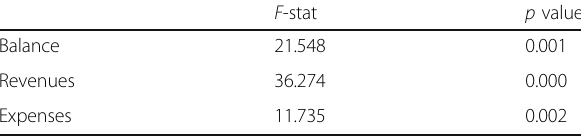
Table 8 Wooldridge test for autocorrelation of order